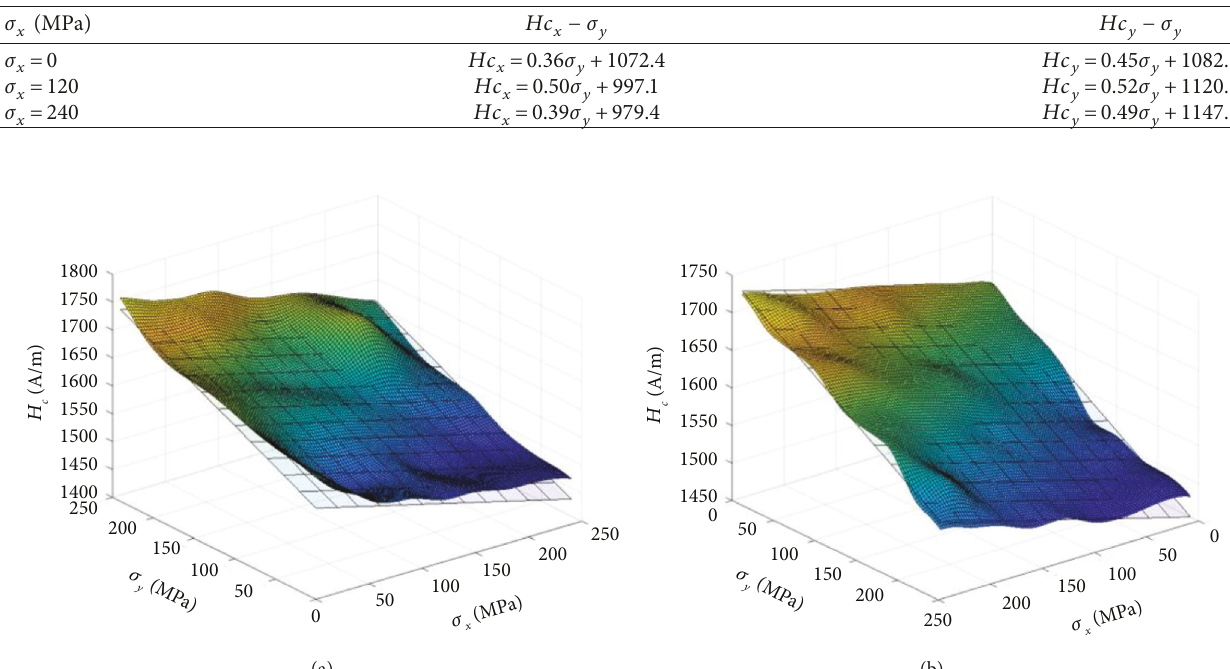
Figure 17: One-time binary fitting of test data of test piece 1. (a) Coercive force fitting of test piece 1 in X direction � − 0 . 4936 σ + 0 . 7491 σ + 1564 . 0. (b) Coercive force fitting of test piece 1 in Y direction Hc Hc x x y